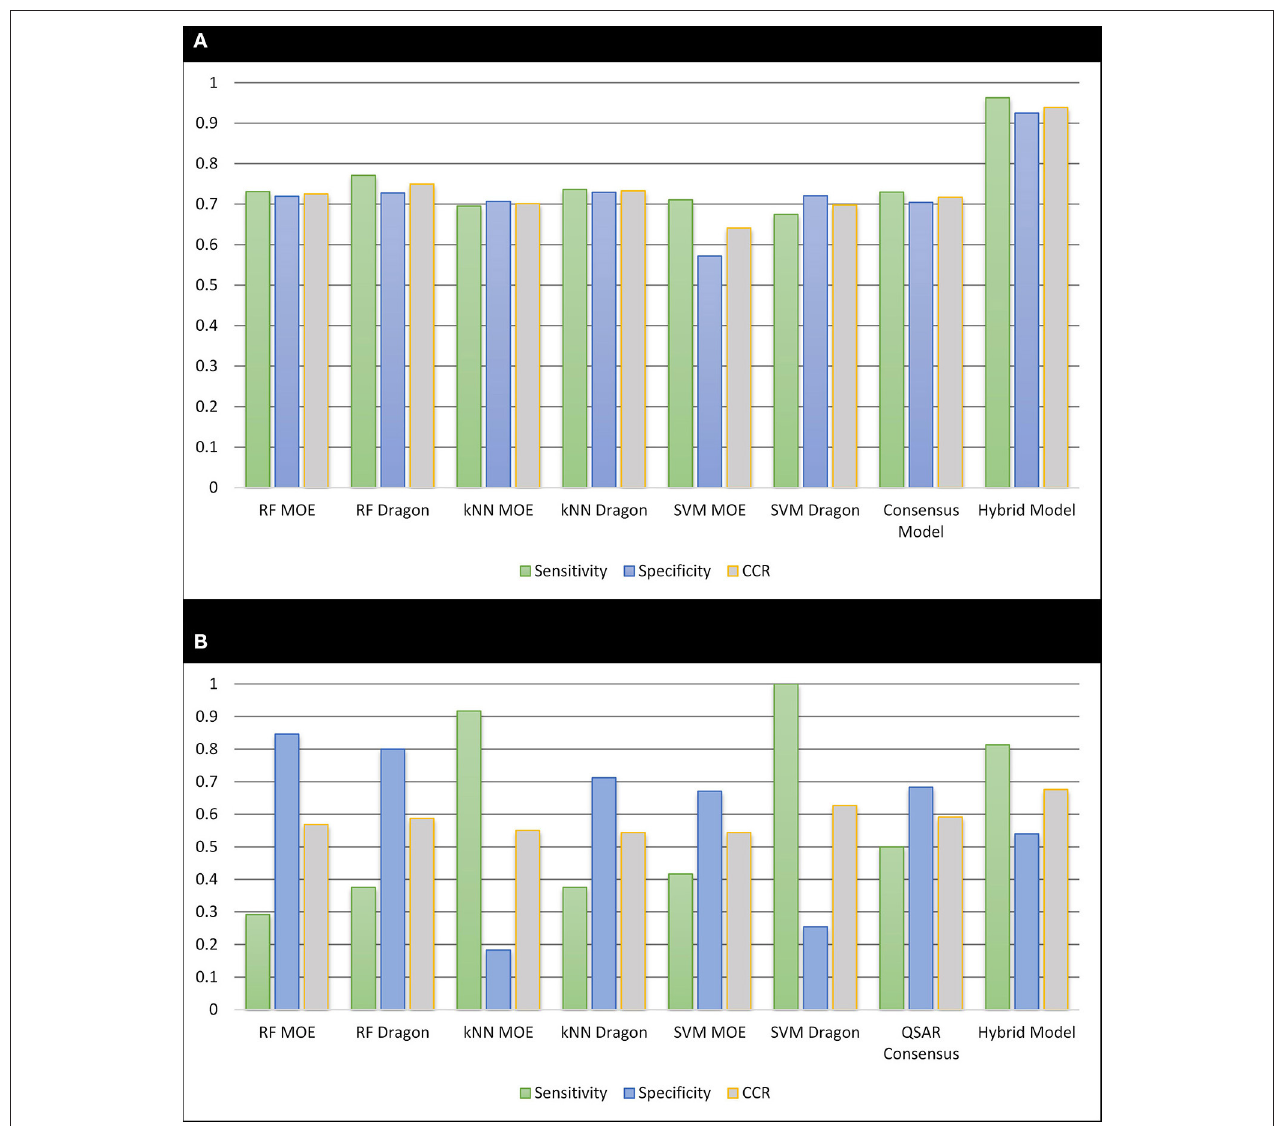
FIGURE 2 | The performance of all resulting models. (A) Cross-validation of the 518 training set compounds; (B) external validation of 264 unknown